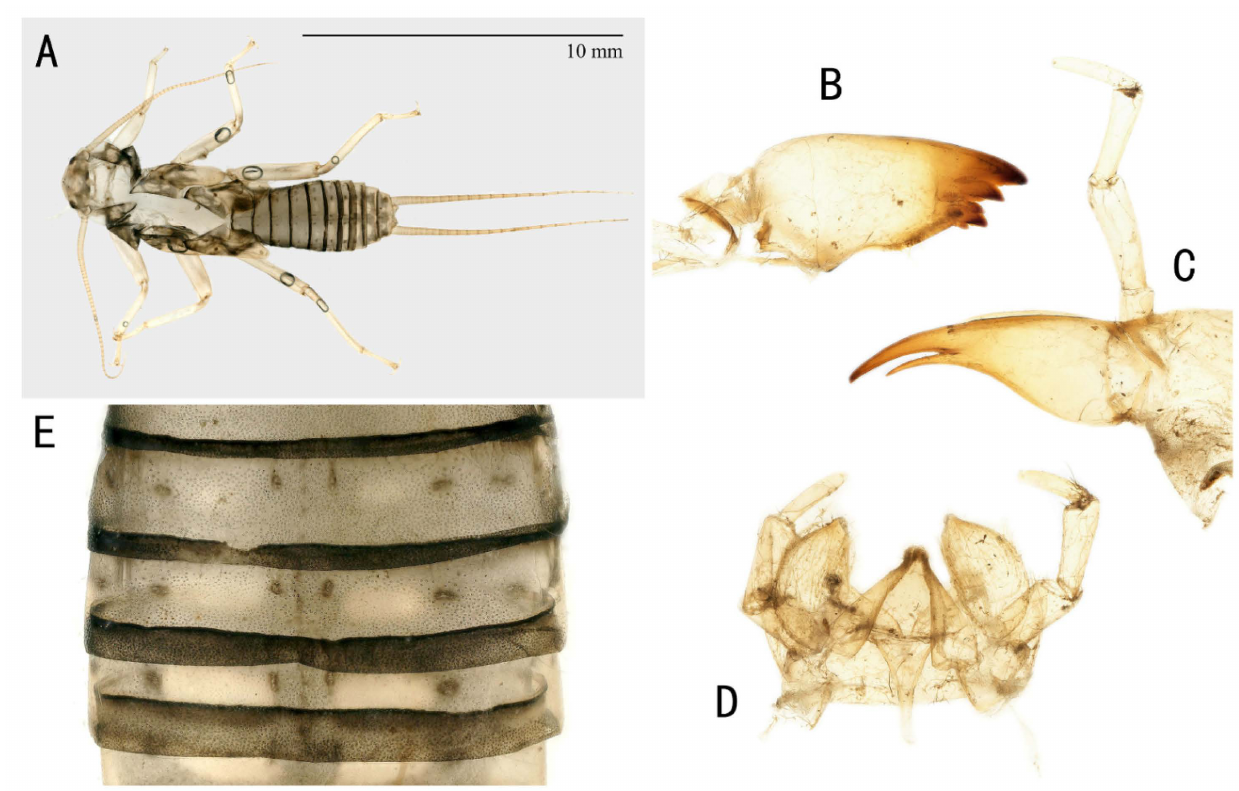
Figure 11. Filchneria zhouchangfai from Anhui, shed skin. ( A ) nymph habitus; ( B ) mandible; ( C ) lacinia; ( D ) labium, ventral; ( E ) tergal stripes and dots.